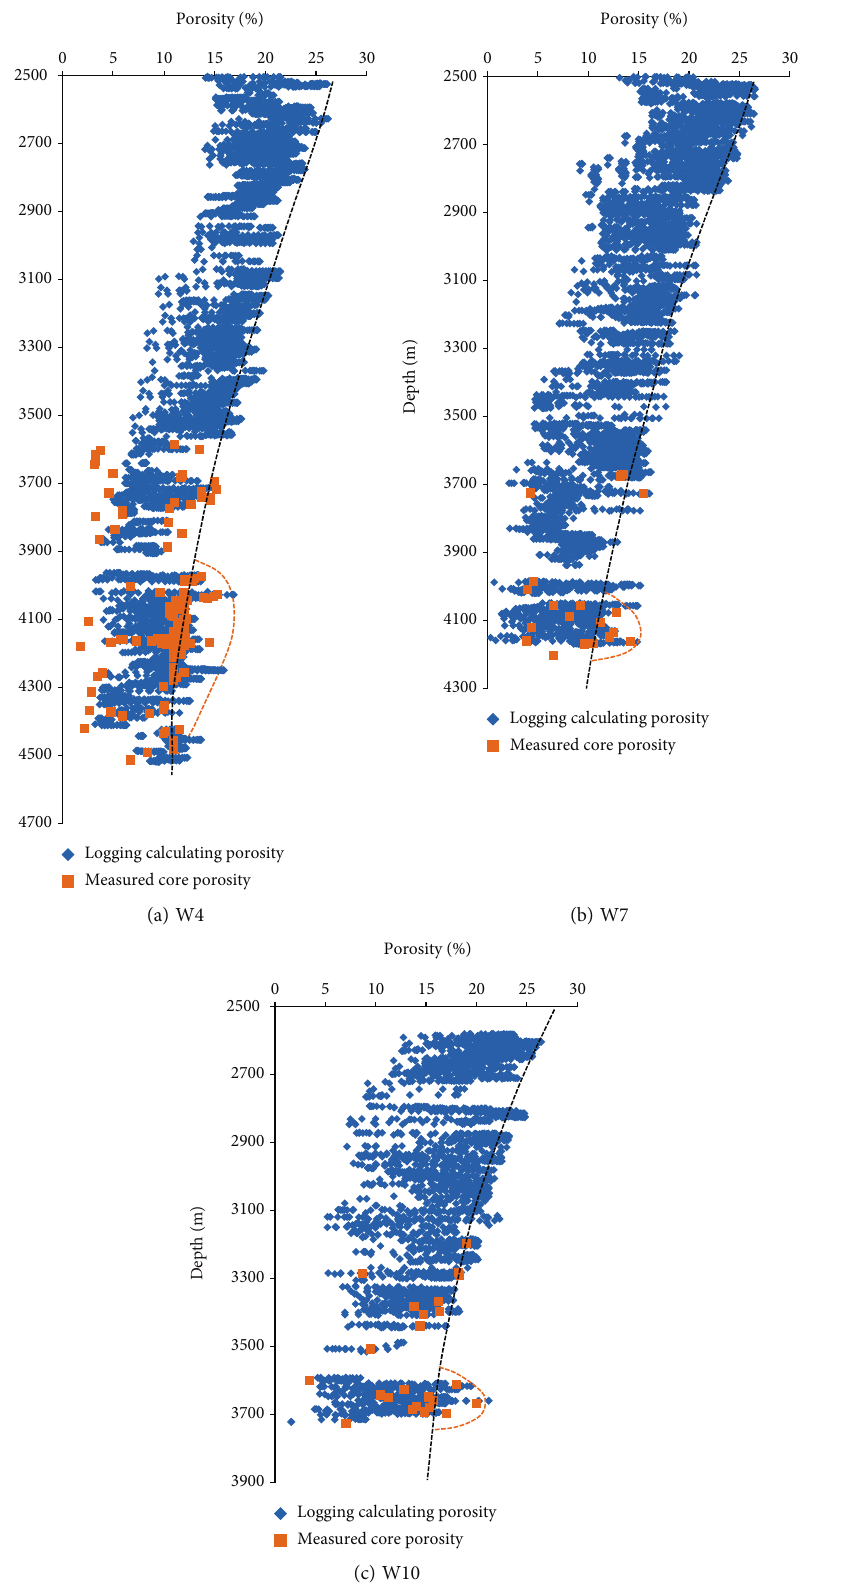
Figure 14: The relationship between the depth and the porosity (the logging calculating porosity and the measured core